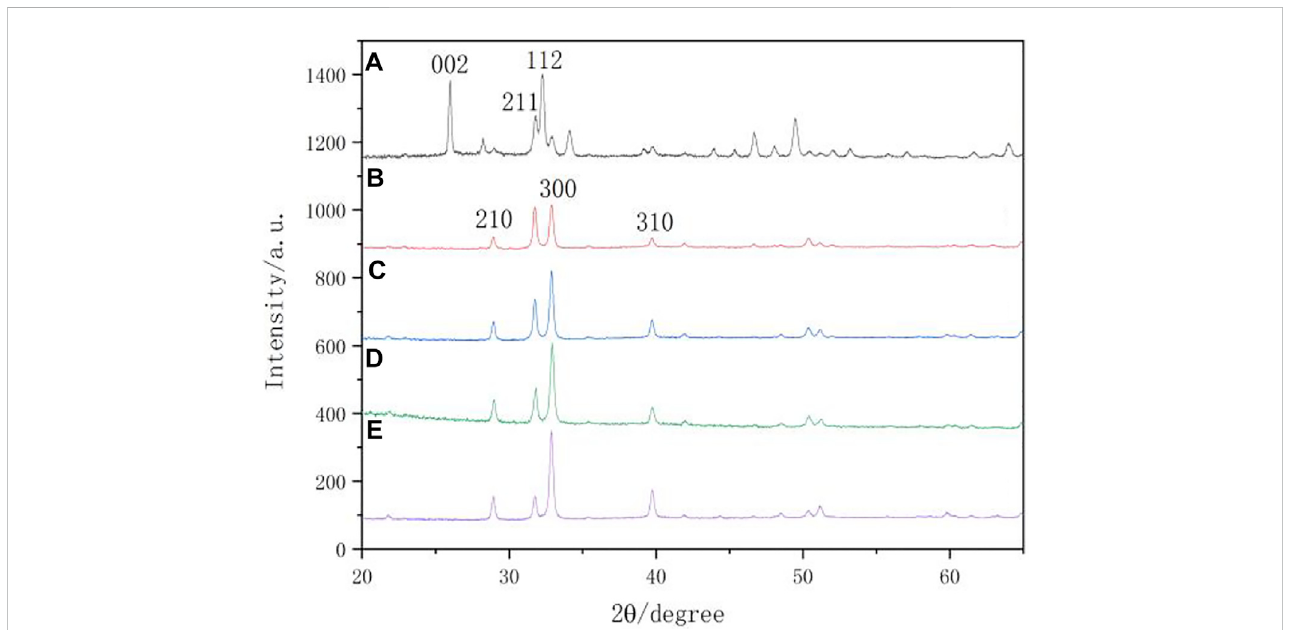
FIGURE 8 XRD spectra. (A) native enamel; (B) remineralizing medium; (C) studied peptide 2; (D) studied peptide 1; (E) fl uoridate.